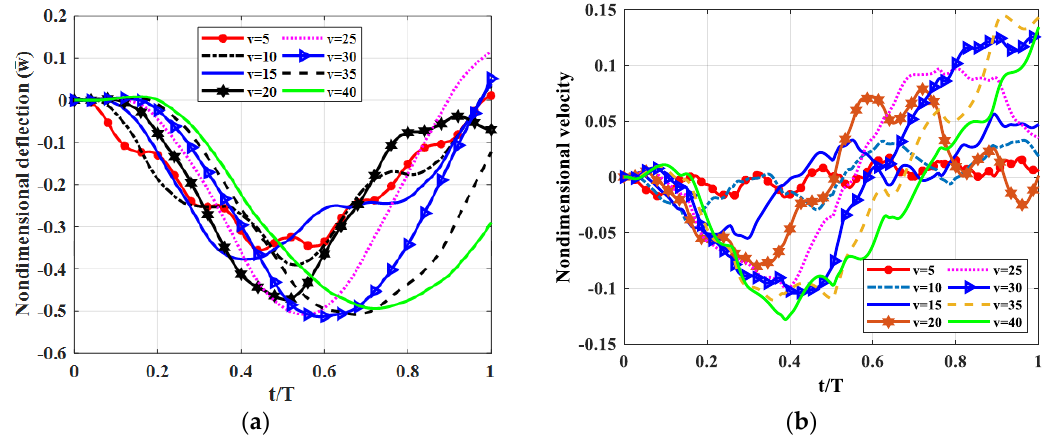
Figure 8. Dynamic deflections of the center point of the plate versus time for different velocities. ( a ): Nondimensional deflection w versus time, ( b ): Nondimensional velocity v versus time. Table 6. Maximum deflections, velocities and stress of the plate center point versus time for different velocities.